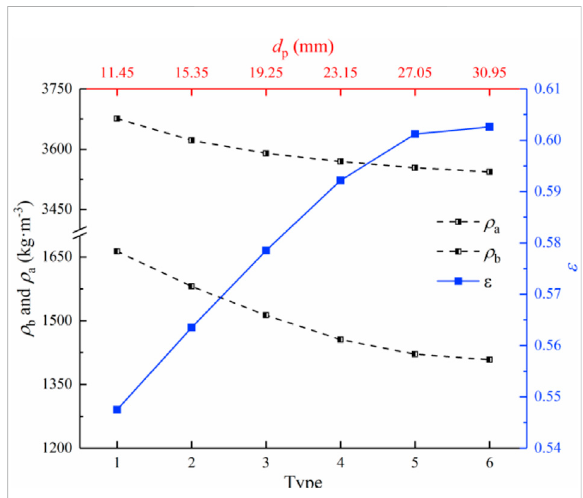
FIGURE 7 Equivalent particle diameter d p , apparent density ρ a , bulk density ρ b and bed voidage ε of six kinds of multi-size